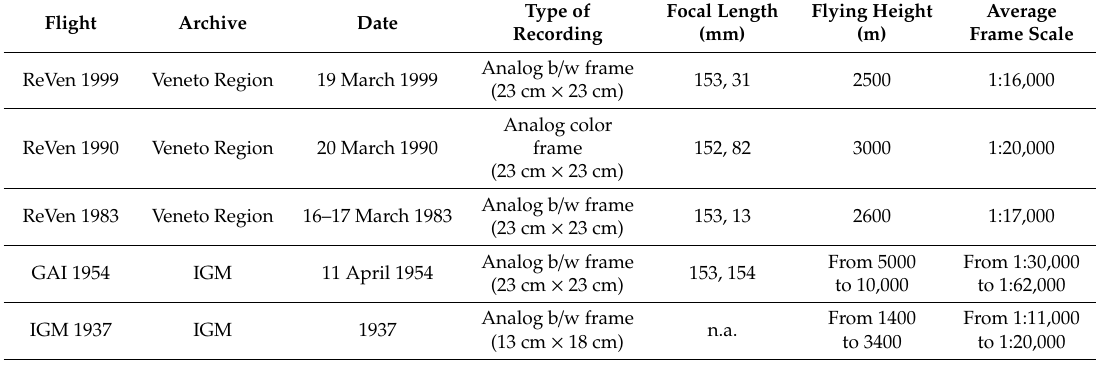
Table 1. List of aerial photographs analyzed for the study.